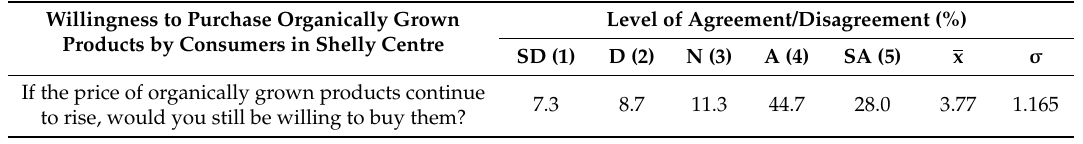
Table 8. Consumers’ willingness to purchase organically grown products regardless of price in Shelly Centre (n =